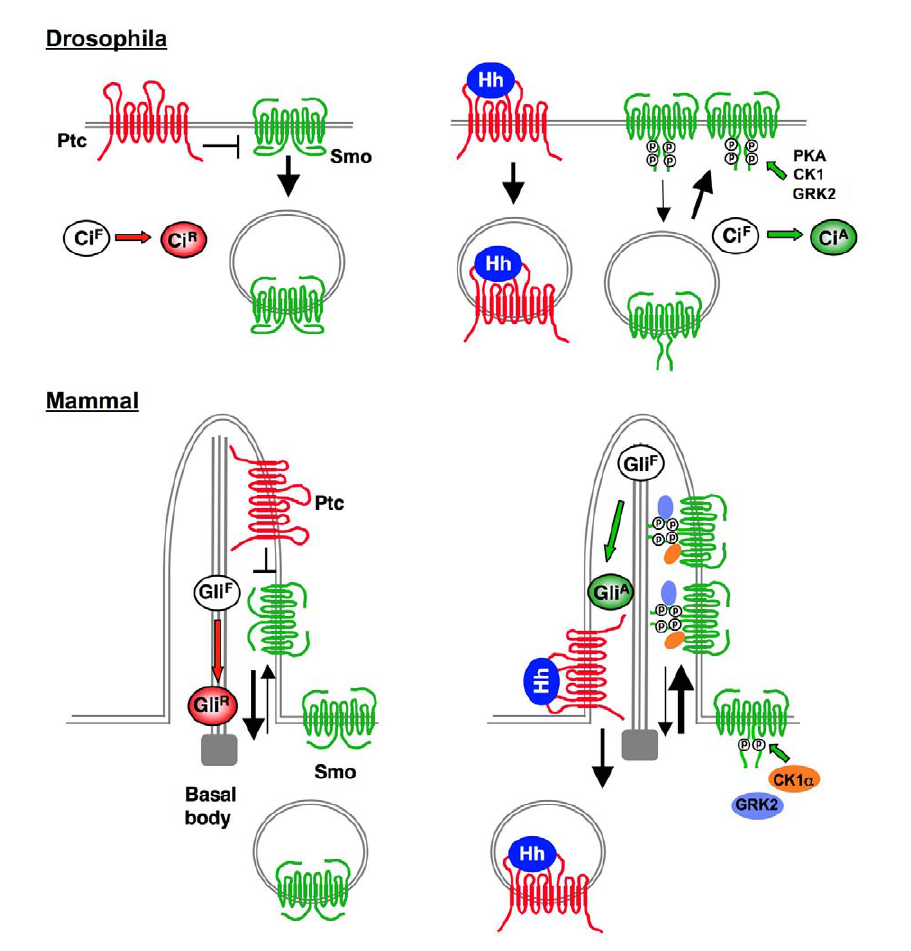
Figure 8. A unified mechanism for Smo activation in different species. Multi-site phosphorylation by distinct but overlapping sets of kinases activates mSmo and dSmo by regulating their subcellular localization and conformation. See text for details.